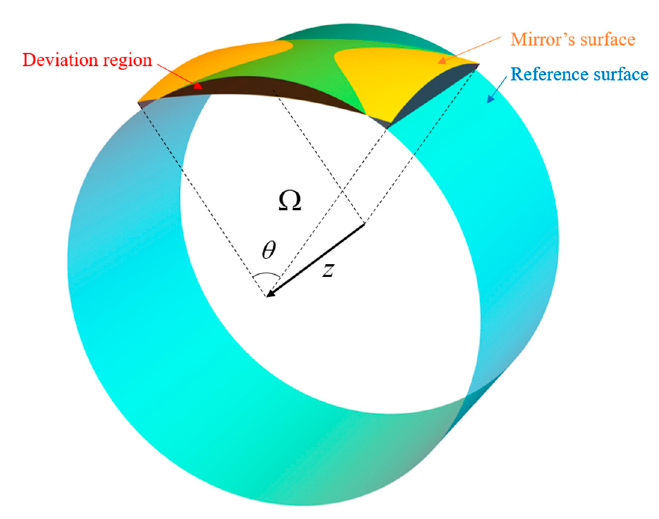
Figure 2. The deviation region between the mirror’s surface and the reference surface. In the figure, Ω is the integral region and θ is the angle formed by the mirror’s edge and the Z-axis of the cylindrical coordinate system.